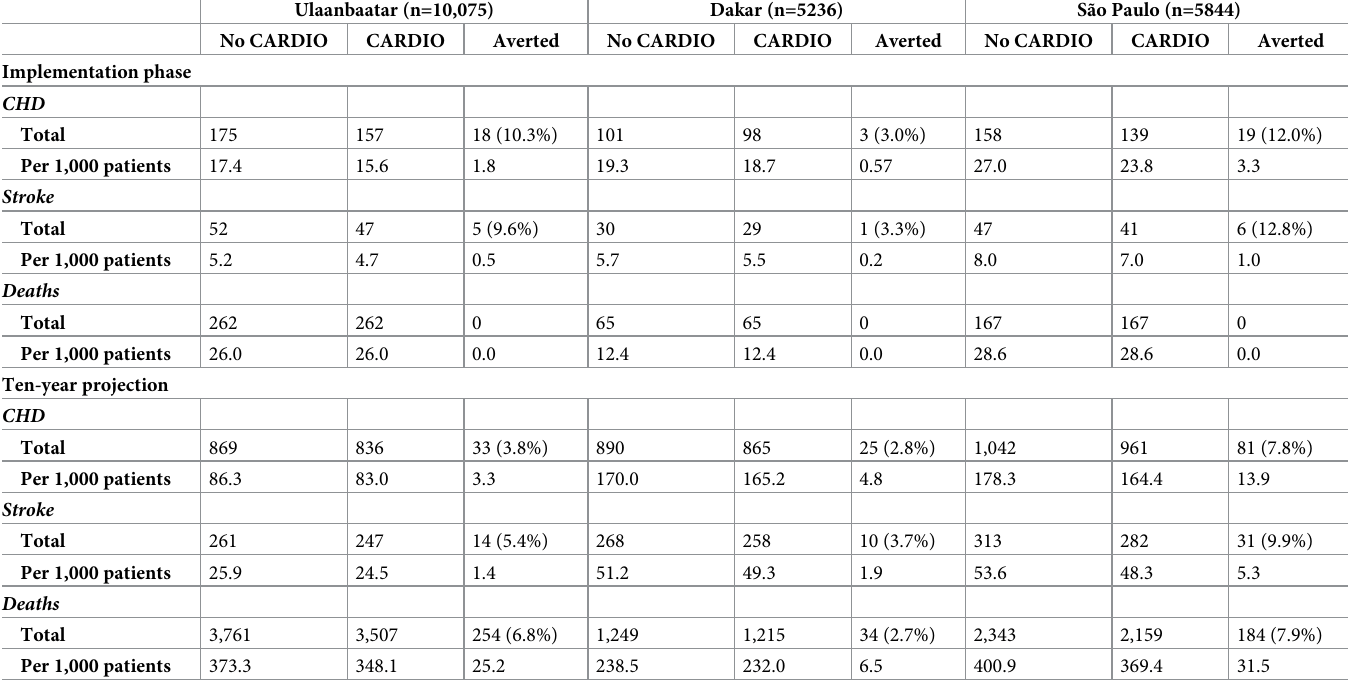
Table 4. Estimated CHD events, strokes, deaths, and events averted following implementation of the CARDIO4Cities approach in Ulaanbaatar, Dakar, and S ã o Paulo for a 2-year implementation phase and a 10-year projection phase. Event projections for “No CARDIO” assume control rates consistent with baseline control rates (3% for Ulaanbaatar, 13% for Dakar, and 12% for S ã o Paulo). “CARDIO” assumes control rates equivalent to those measured in the last quarter of CARDIO imple- mentation (19% for Ulaanbaatar, 19% for Dakar, and 30% for S ã o Paulo). Control rates were assumed to remain consistent throughout the projection period.